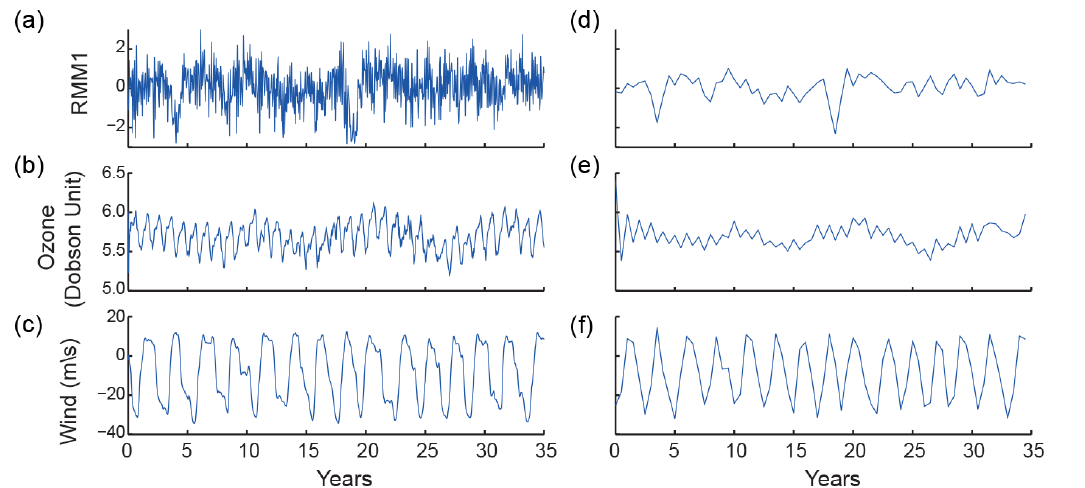
Figure 1. On the right are the time series resampled at a 10d rate of the first component of the MJO index (a, d) , ozone spatially averaged in the equatorial region (b, e) , and equatorial stratospheric wind (c, f) . On the left is the same with band with a resampling rate of 6